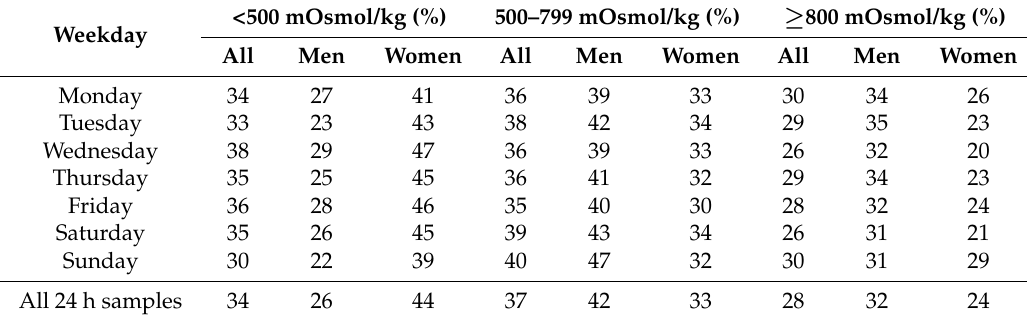
Table 3. Percentage of 24 h urine osmolality within selected categories on weekdays for men and